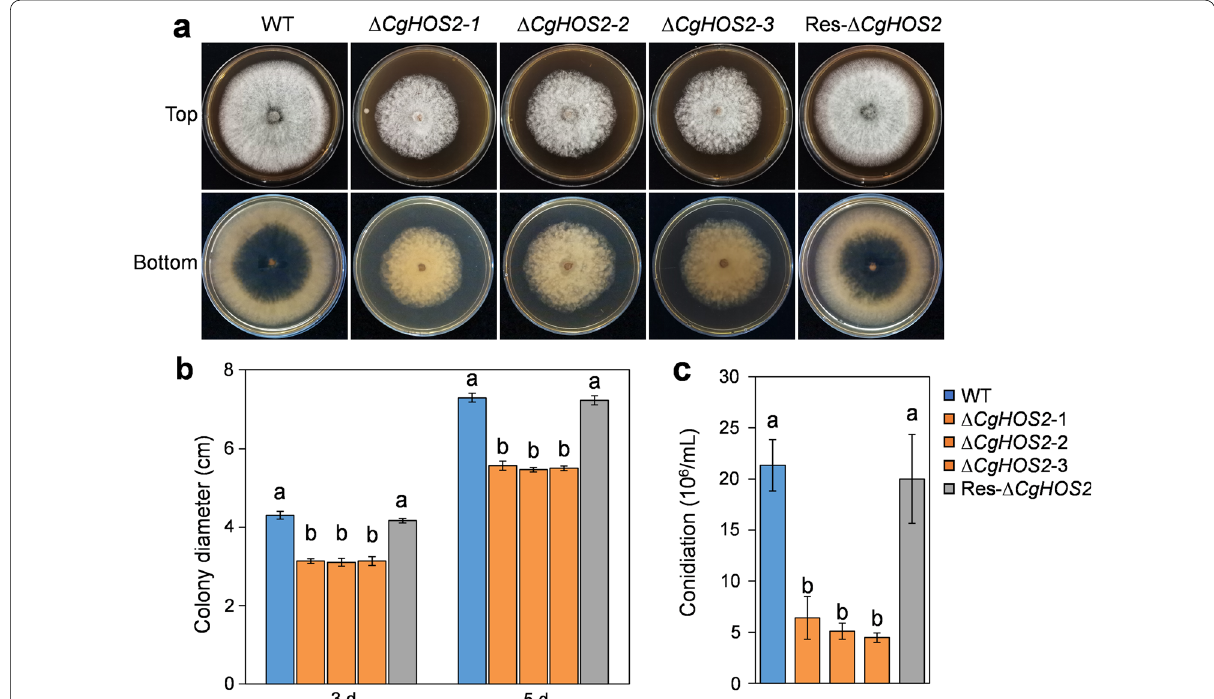
Fig. 3 CgHOS2 is involved in vegetative growth and conidiation. a Colony morphology of the WT, the CgHOS2 knockout mutant ∆ CgHOS2 , and the complementation strain Res-Δ CgHOS2 cultured on PDA media for 6 days. b Diameters of colonies of fungi cultured on PDA media for 3 and 5 days. c Conidiation after the fungi were incubated in PDA broth for 4 days. The values were analyzed with Duncan’s multiple range tests. The columns with different letters indicate significant differences ( P <